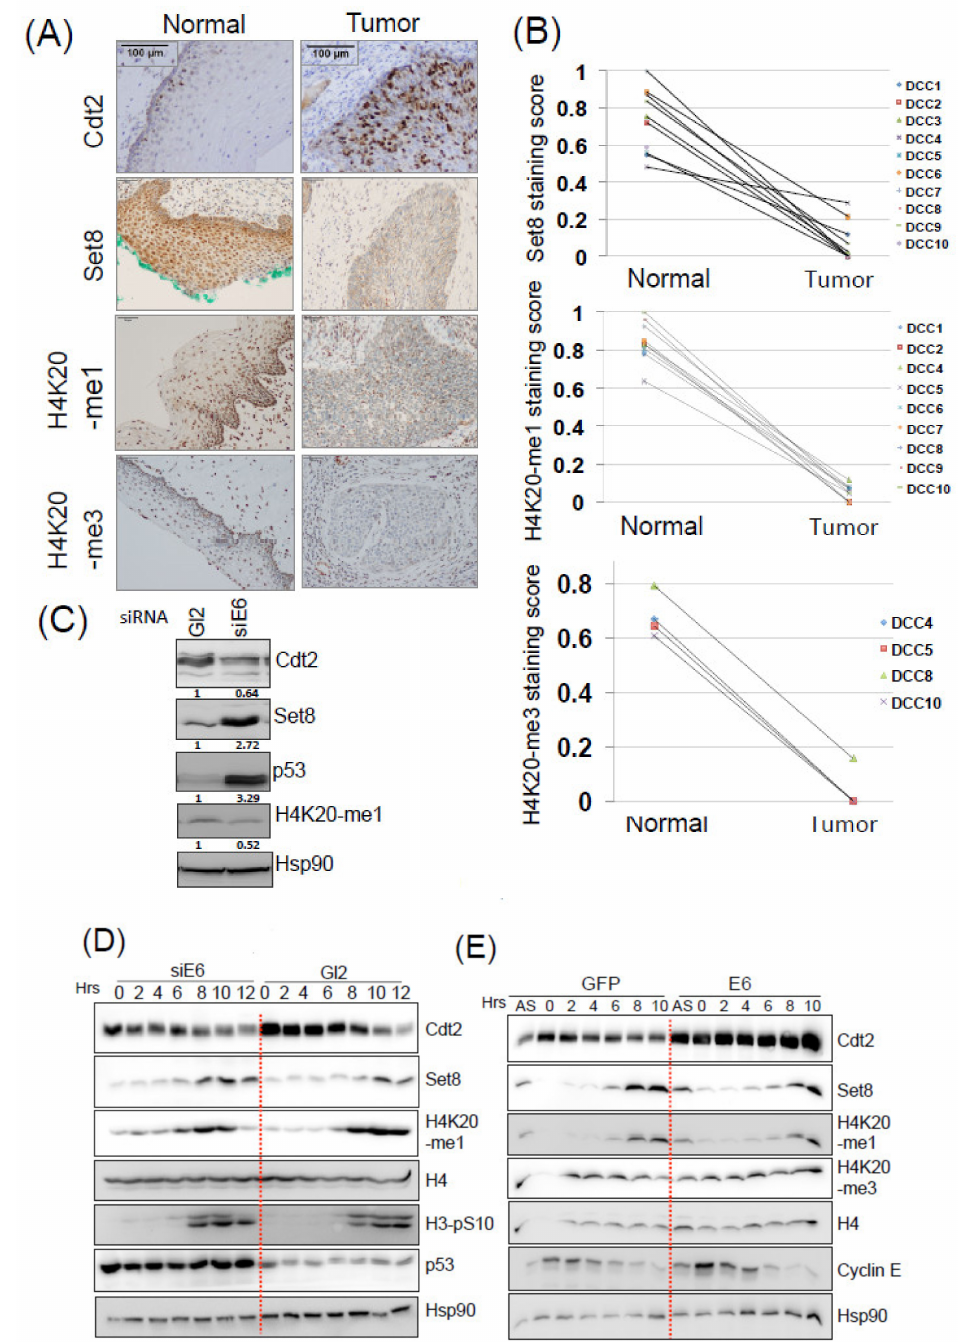
Figure 1. ( A ) Immunohistochemical staining of Cdt2, Set8, H4K20-me1 and H4K20-me3 cells in cervical cancer and adjacent normal tissues. ( B ) Summary of staining scores for Set8, H4K20-me1 and H4K20-me3 in normal and cancerous tissue. DCC 1–10 denotes individual patients for each normal and cancer pairs. ( C ) HeLa cells were transfected with control (Gl2) or indicated siRNAs and collected 48 h after transfection. The cell lysates were then immunoblotted with indicated antibodies. ( D ) HeLa cells were transfected twice with control (Gl2) or HPV-E6 siRNAs before and during the double thymidine block (DTB). Cells were collected at indicated time points after release from DTB and subjected to immunoblotting with indicated antibodies. ( E ) HeLa cells were transfected with GFP or HPV-16E6 expressing plasmids followed by double thymidine block (DTB). Cells were collected at indicated time points after DTB and subjected to immunoblotting with indicated